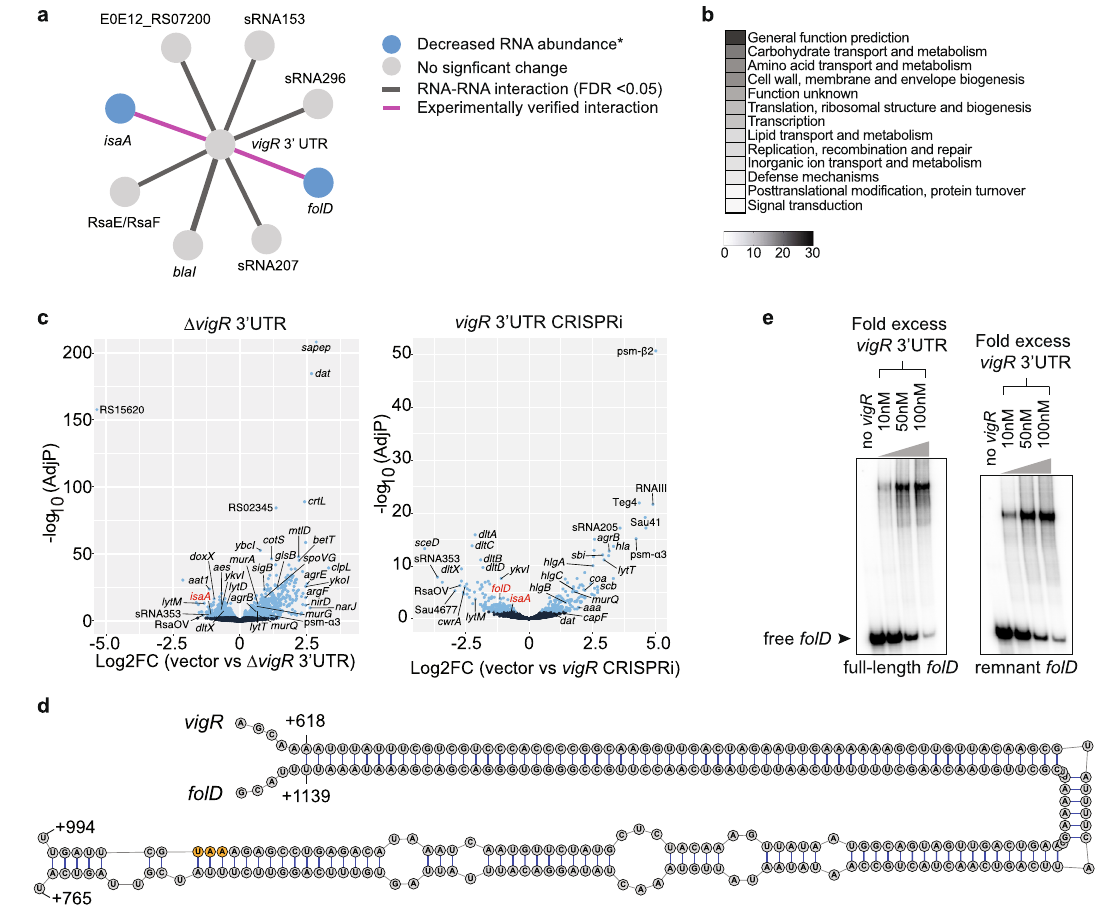
Fig. 5 The 3 ′ UTR of vigR regulates cell wall metabolism. a Sub-network of RNase III-CLASH RNA – RNA interactions with vigR 3 ′ UTR. *Target RNA abundance signi fi cantly decreased in JKD6008 vigR Δ 3 ’ UTR or CRISPRi knockdown strains (see panel c ). b Clusters of orthologous (COG) classes detailed for differentially expressed transcripts found in both vigR Δ 3 ′ UTR and CRISPRi knockdown strains (adjusted p < 0.05). The most abundant COG classes are listed in numerical order. c Volcano plots of differential expression in JKD6008 vs JKD6008 vigR Δ 3 ′ UTR ( left ) and JKD6008 pSD1 (vector control) vs pSD1::sgRNA- vigR 3 ′ UTR (CRISPRi knockdown) ( right ). Statistically signi fi cant changes in RNA abundance are indicated in light blue (adjusted p < 0.05). DESeq2 calculates a two-sided p- value based on the Wald statistic that is corrected for multiple testing using the Benjamini – Hochberg method. Transcripts for isaA and folD are indicated by red text. d Base pairing interaction predicted to form between the vigR 3 ′ UTR and folD mRNA. The folD stop codon is indicated in orange. e EMSA analysis of RNA – RNA interactions between radiolabelled full-length folD mRNA and the vigR 3 ′ UTR ( left ), and radiolabelled sub-fragment of folD ( right ). Approximately 50 fM of folD was radiolabelled and titrated against increasing concentrations of vigR 3 ′ UTR (indicated top). The migration of free folD mRNA is indicated by the black